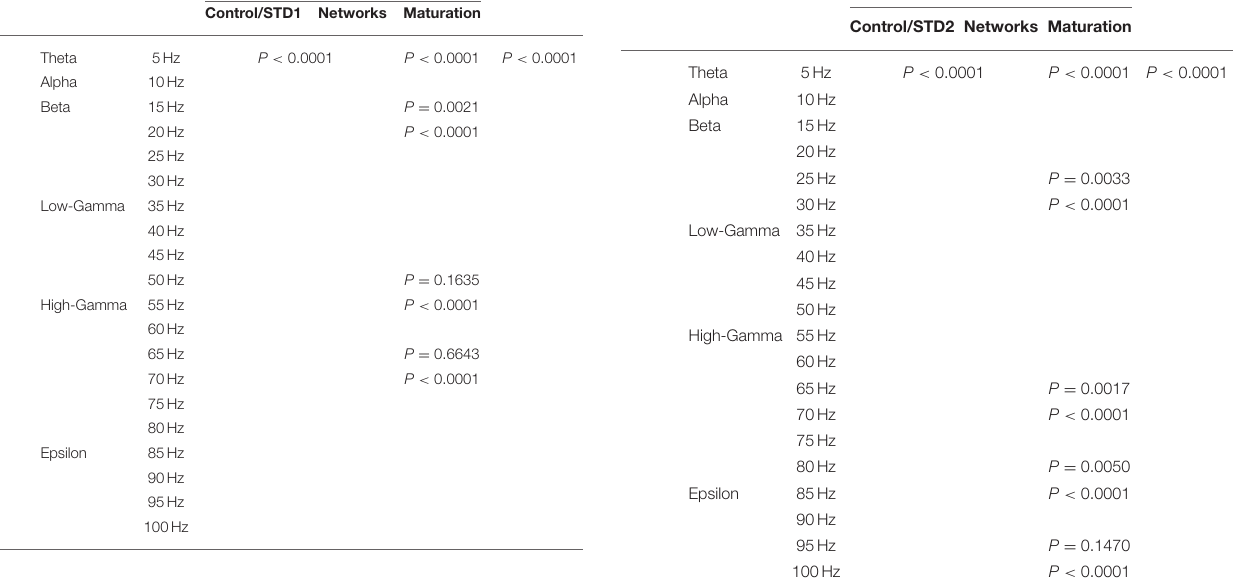
TABLE 1 | Three-way ANOVA for STD1. Ranges